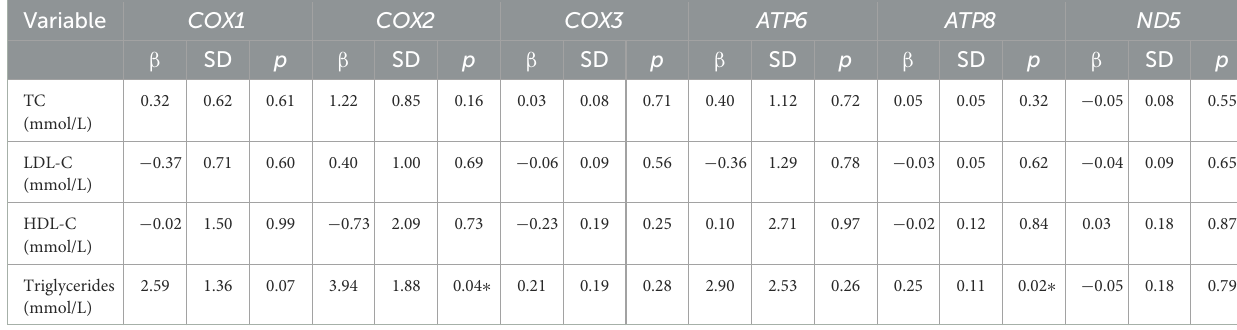
TABLE 4 Associations between lipid levels and the mtDNA methylation levels.